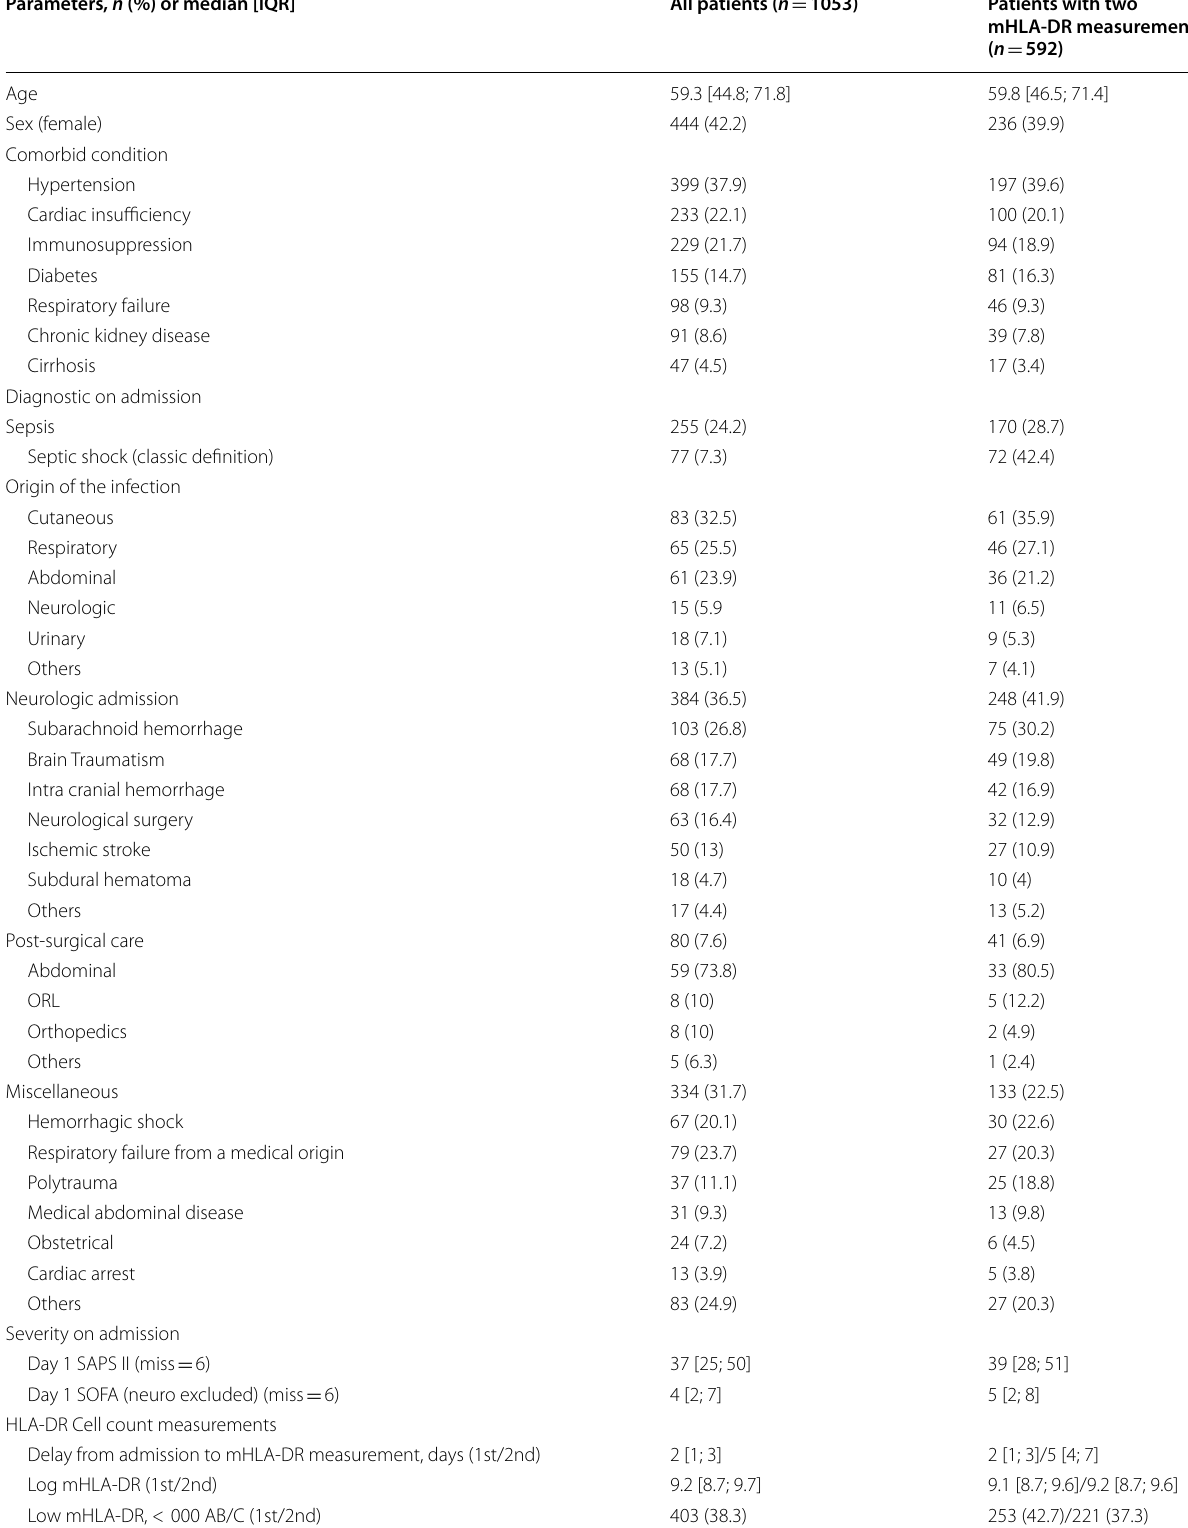
Table 1 Characteristics of the global cohort and patients having 2 measurements of mHLA-DR Parameters, n (%) or median [IQR] All patients ( n